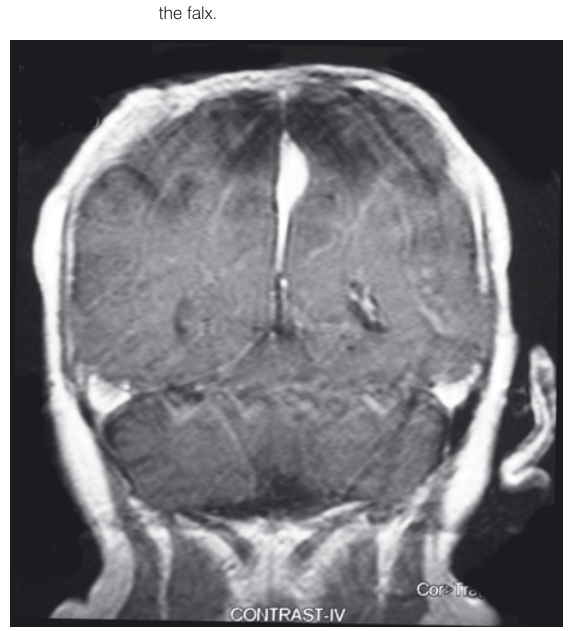
Figure 3. Postoperative coronal T1-weighted MRI study with contrast administration after 1 year. Craniectomy. No evidence of tumor recurrence. Small residual tumor in the